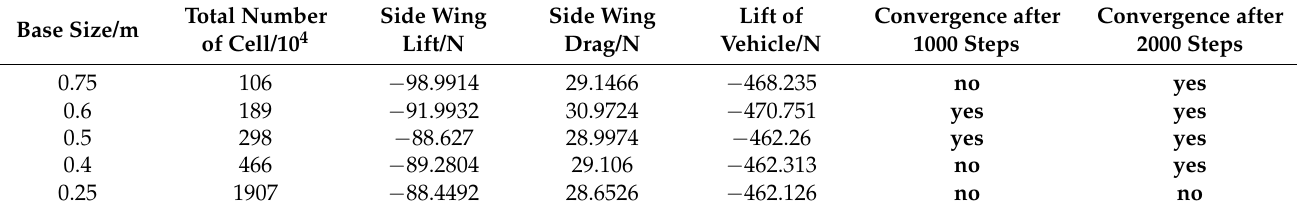
Table 1. Grid sensitivity analysis